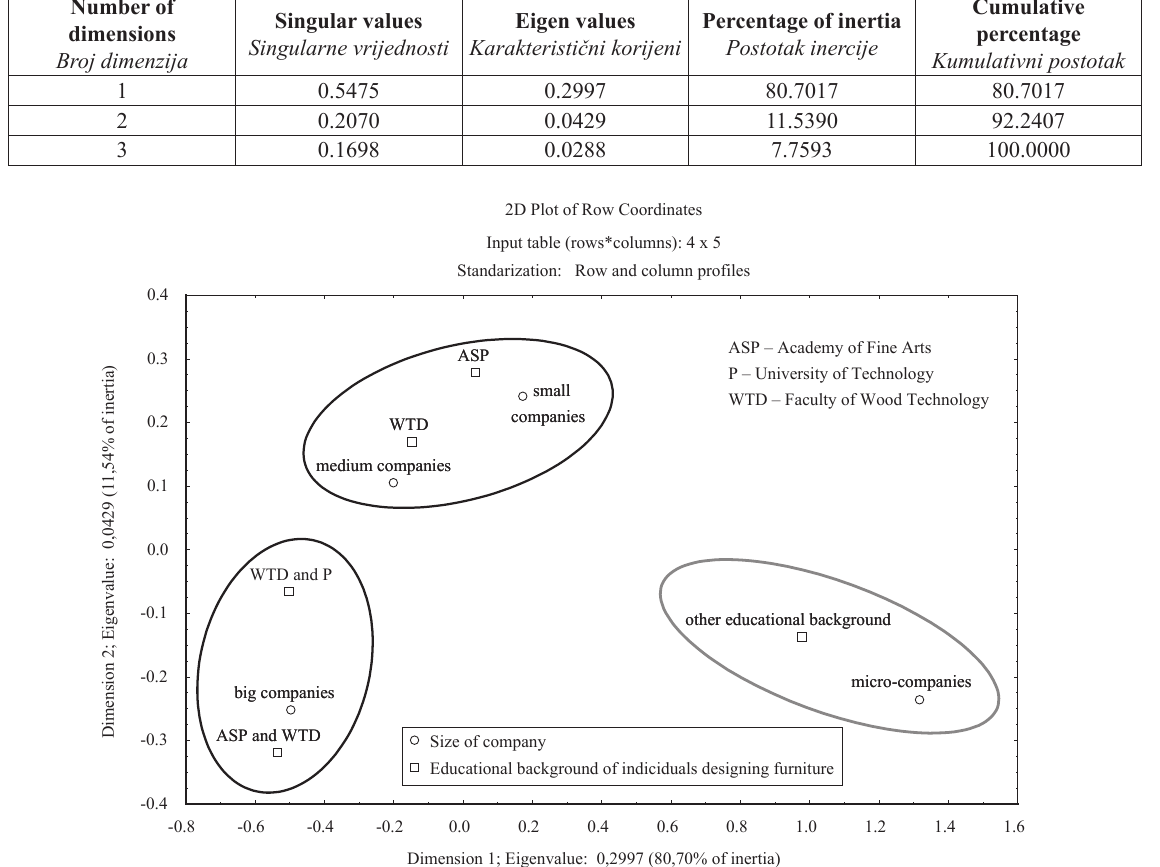
Figure 8 Graphic presentation of results of correspondence analysis of variables: size of enterprise and vocational training of individuals designing